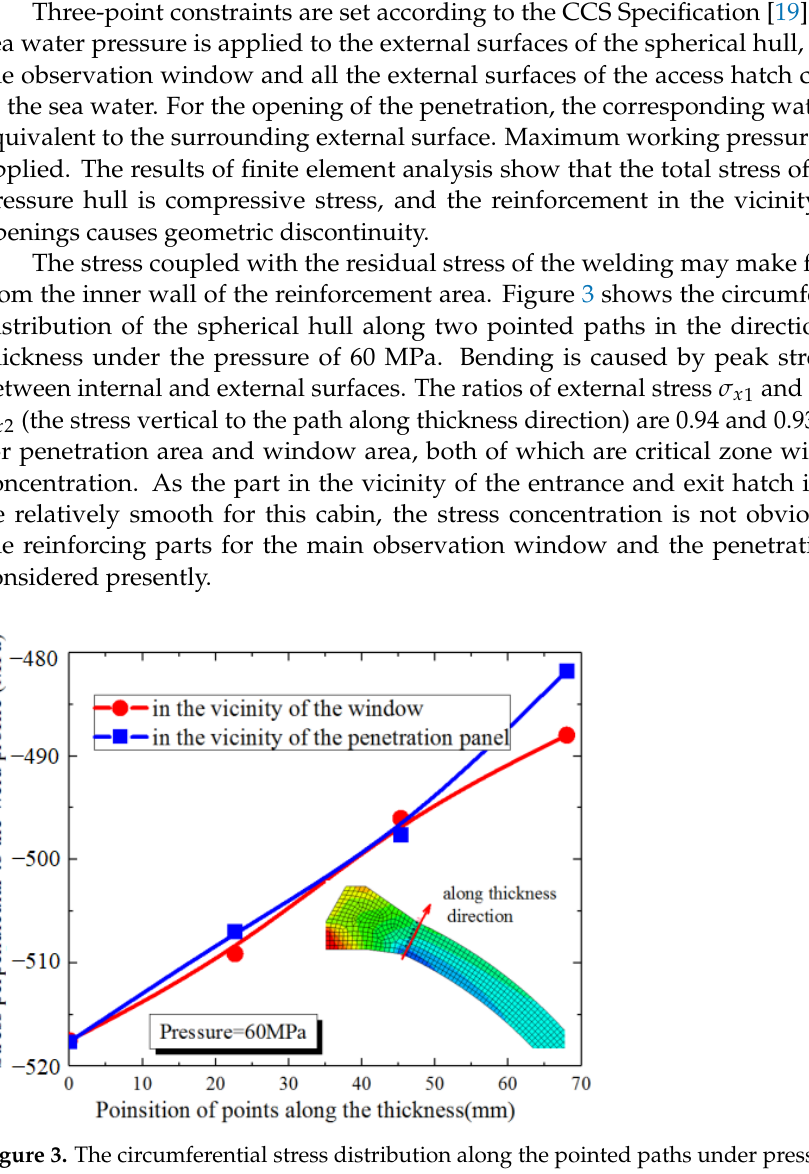
Figure 2. Sketch of the manned cabin used in deep-sea manned submersible to the depth of 6000 m.